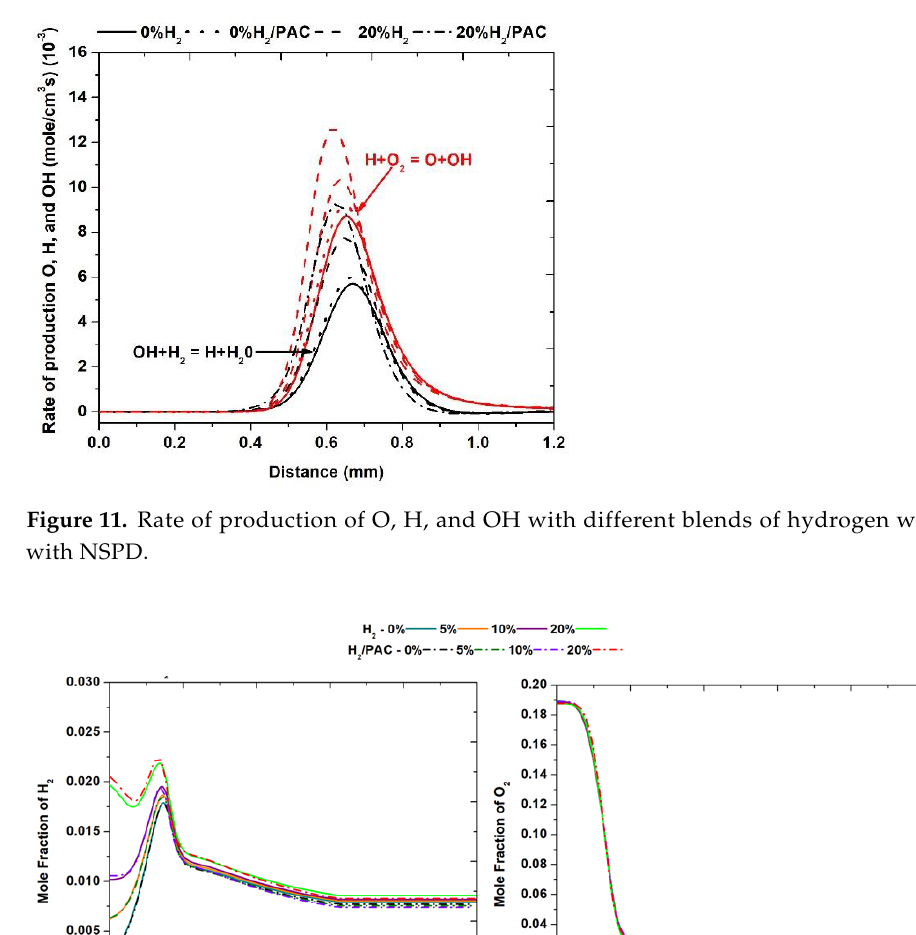
Figure 12. Mole fraction profiles of H 2 and O 2 with different blends of hydrogen without or with